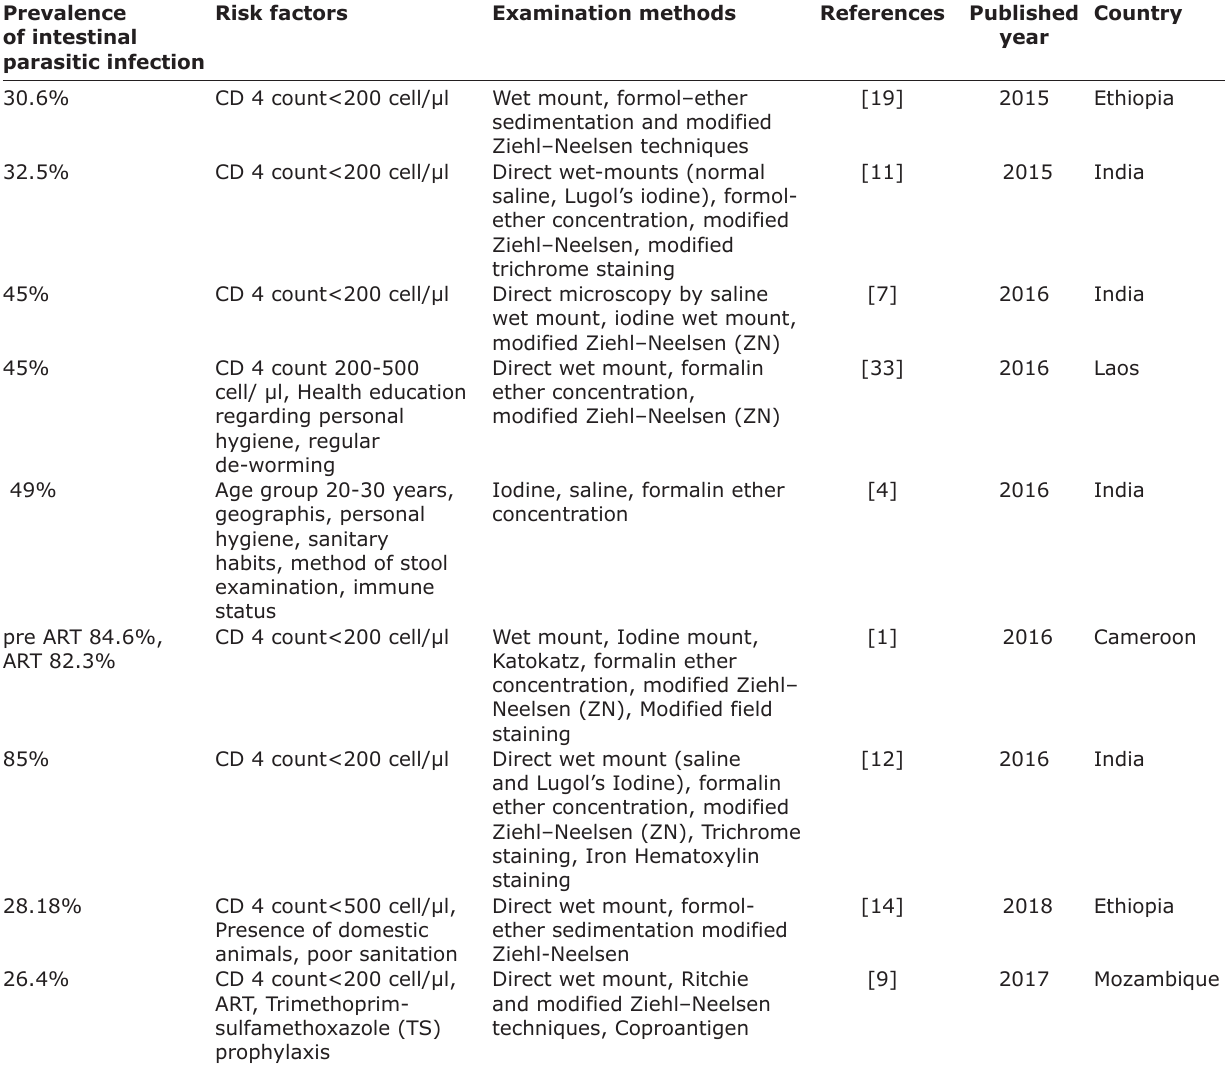
Table-2: Prevalence, risk factors, and examination methods of opportunistic parasitic infection in HIV/AIDS patients based on geographical regions. Prevalence of intestinal parasitic